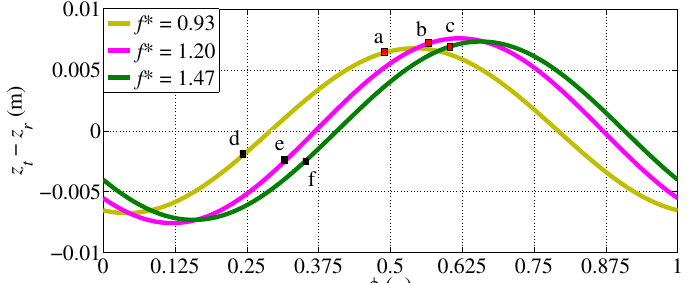
Figure 6. Displacement of the trailing edge relative to the leading edge, z t − z r , for different f ∗ in a flapping cycle.